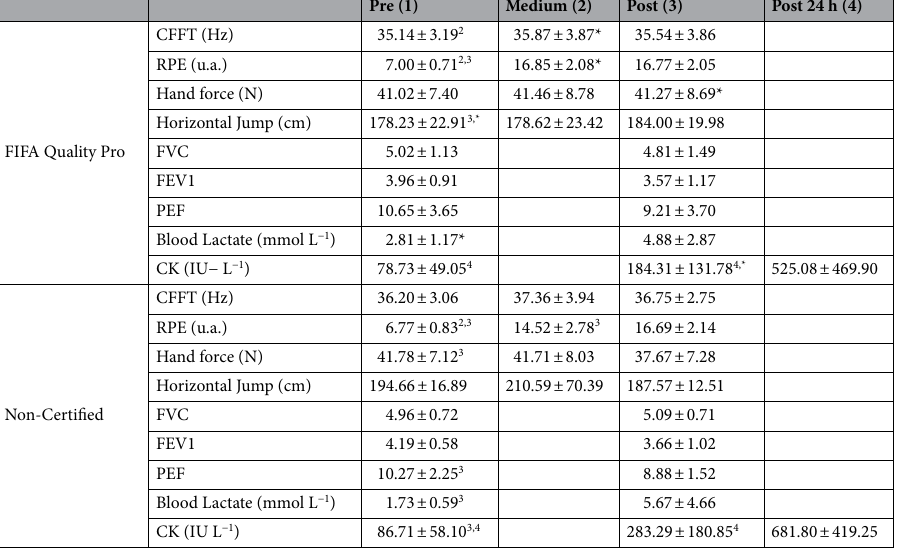
Table 4. Effect of BEAST 90 on attention RPE, physical, respiratory and biomarker parameters in a FIFA Quality Pro and non-certified artificial turf football fields. *Significant differences between FIFA Quality Pro and non-certified artificial turf fields ( p < 0.05). 1, 2, 3, 4 Significant differences at half-time (2), immediately post-test (3), 24 h post-test (4) ( p < 0.05). CFFT: critical flicker fusion threshold; RPE: rated of perceived